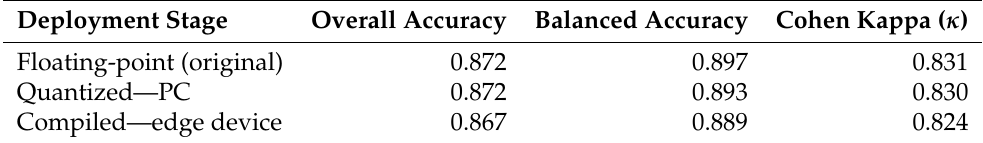
Table 6. The change of metrics across different stages of Deep Earth deployment.